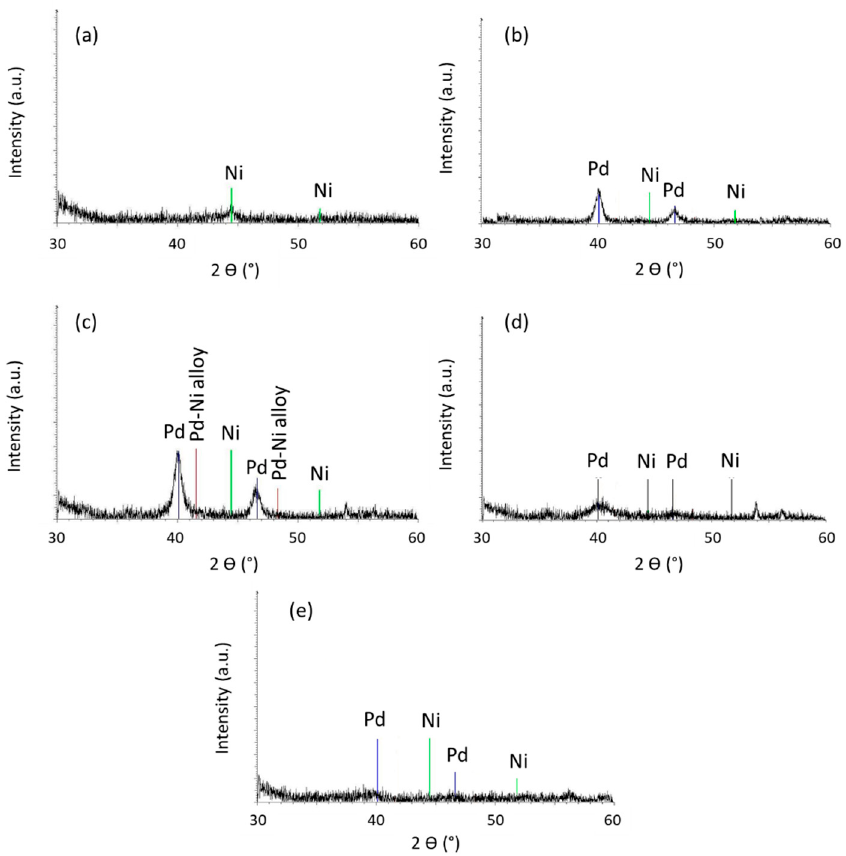
Figure 1. XRD patterns of ( a ) Ni100, ( b ) Pd33Ni67, ( c ) Pd50Ni50, ( d ) Pd67Ni33 and ( e ) Pd100 samples. Reference peaks corresponding to Pd (JCPD No. 46-1043 [24]), Ni (JCPD No. 04-0850 [16]) and Pd-Ni alloy (JCPD No. 65-9444 [35]) are denoted on the fi gures.